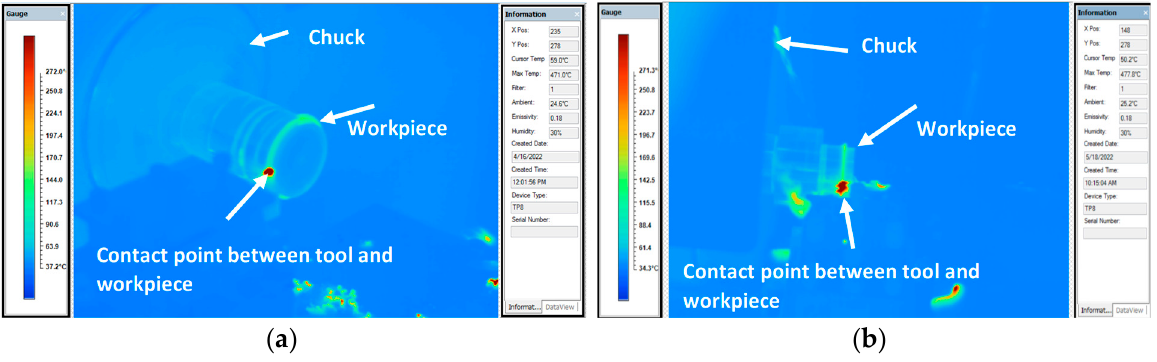
Figure 5. Thermal image for ( a ) conventional and ( b ) wiper inserts. For surface roughness (Ra) measurement, a Rugosurf 90-G type surface testing device from Tesa (Bugnon, Switzerland) was utilized. The measurement parameters were set as follows: cut-off length 0.8, cut-off number 15, and measurement speed 1 mm/sec, and the measurements were performed on the curved surfaces.